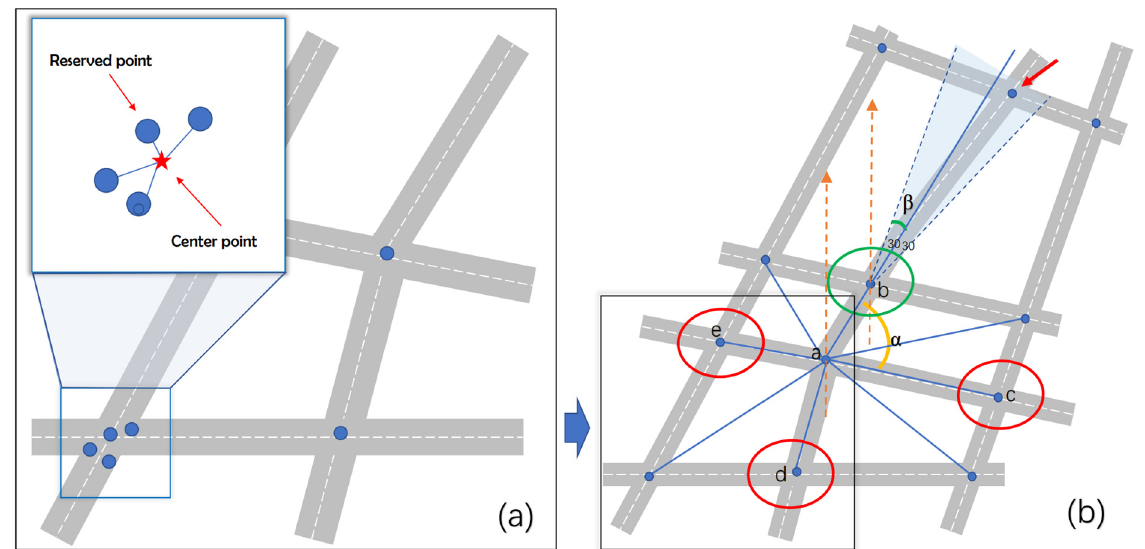
Figure 2. The removal of duplicate POIs using a sliding window ( a ) and the linkage of different POIs ( b ).